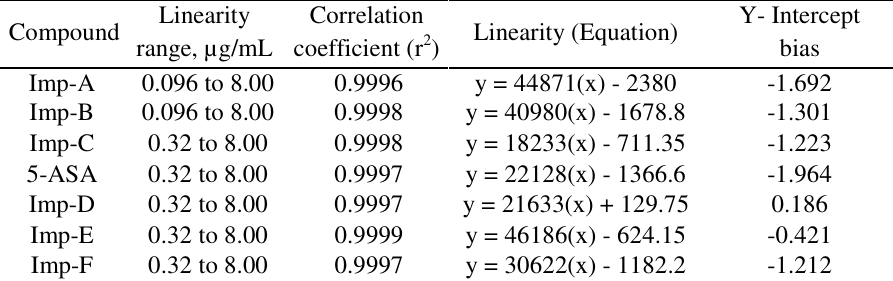
Table 8. Linearity results for 5-ASA and